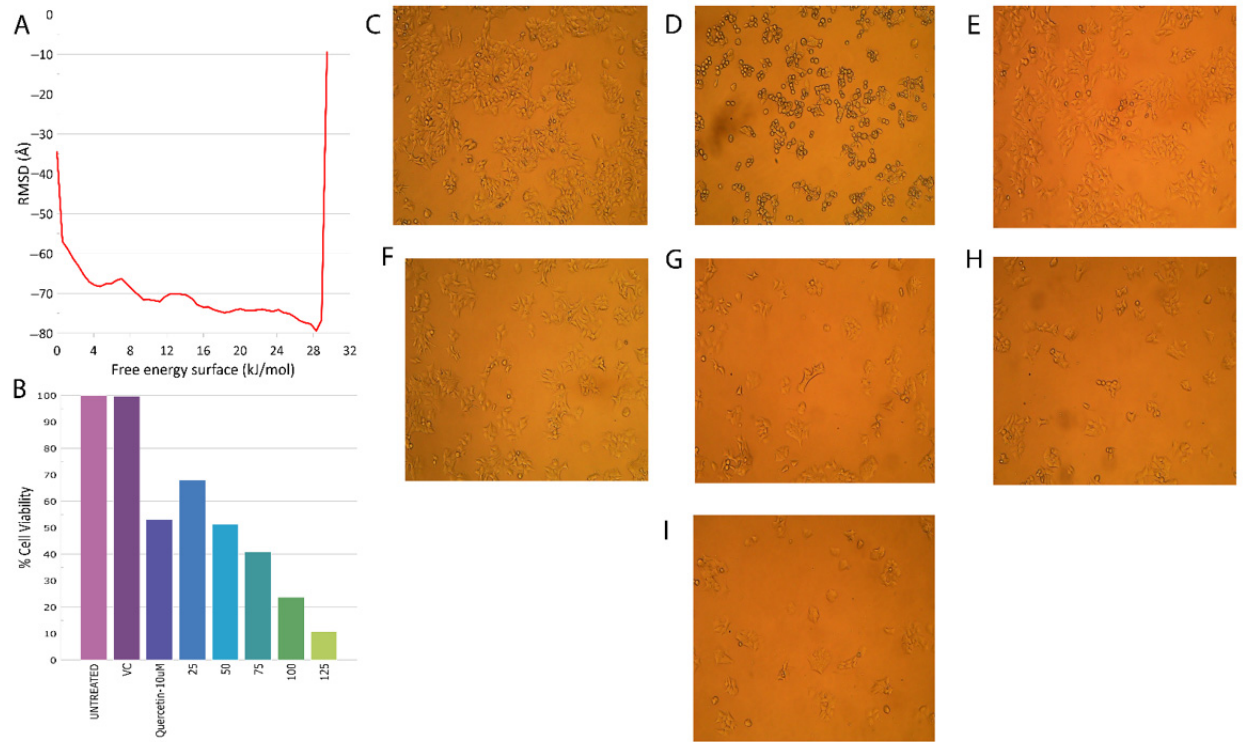
Figure 4. Cell viability was captured during the MTT assay. ( A ) The free energy surface values plotted against distance for metadynamics analysis. ( B ) The bar plot depicts the standard percentage of cell viability and that of samples at various concentrations. ( C – I ) Microscopic cell images of viability tests of untreated, positive control and of 25, 50, 75, 100, and 125 μ g/mL concentrations, respectively.